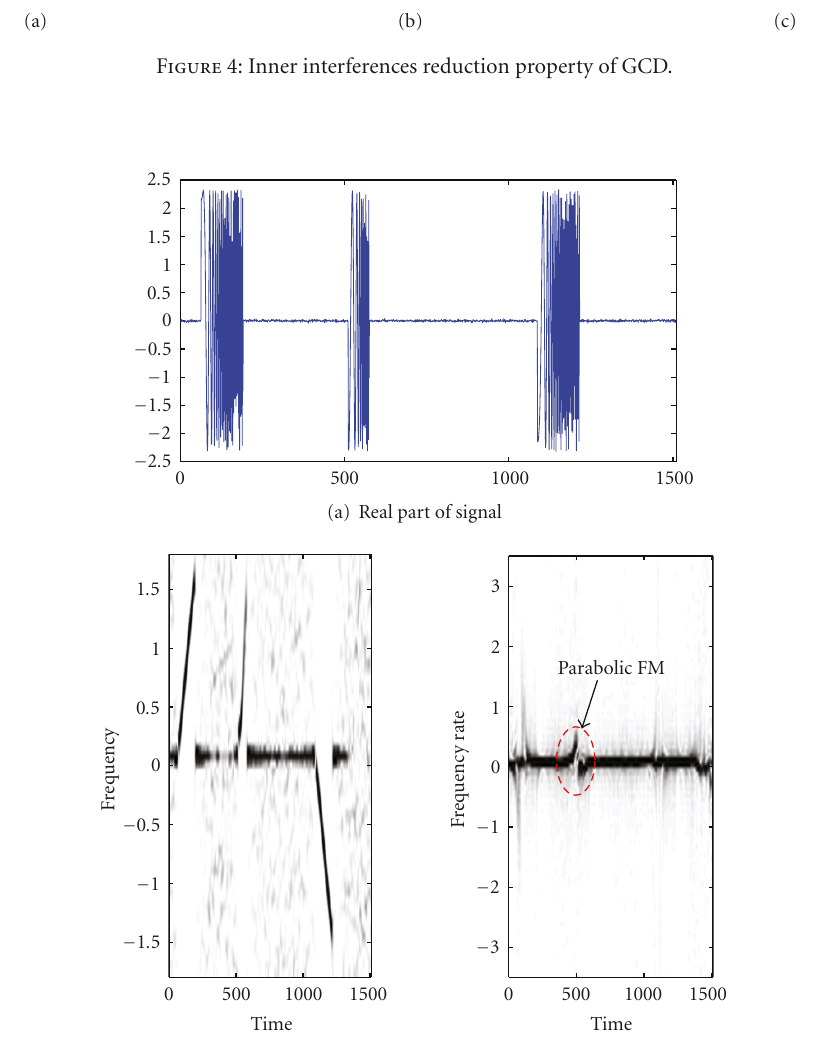
Figure 5: (a) Signal s 2 composed of two linear FM, one parabolic FM and additive noise (SNR = 35dB); (b) GCD 1